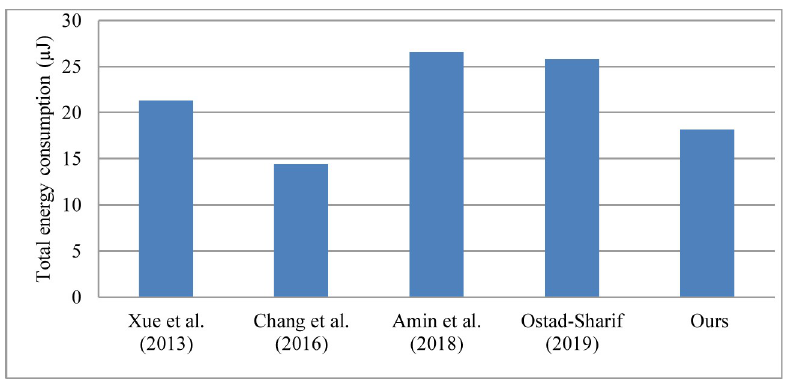
Fig 7. Comparison of energy